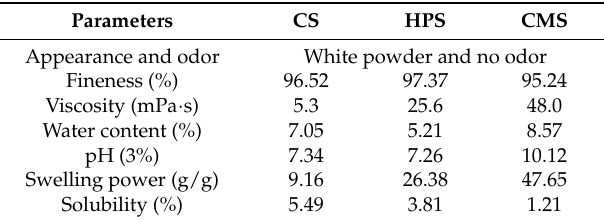
Table 1. The physical and chemical parameters of starches.